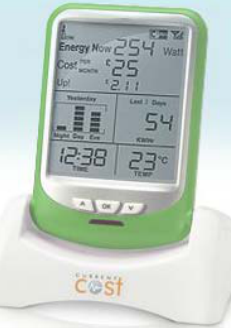
Figure 14. The SmartR Power Monitor from Current